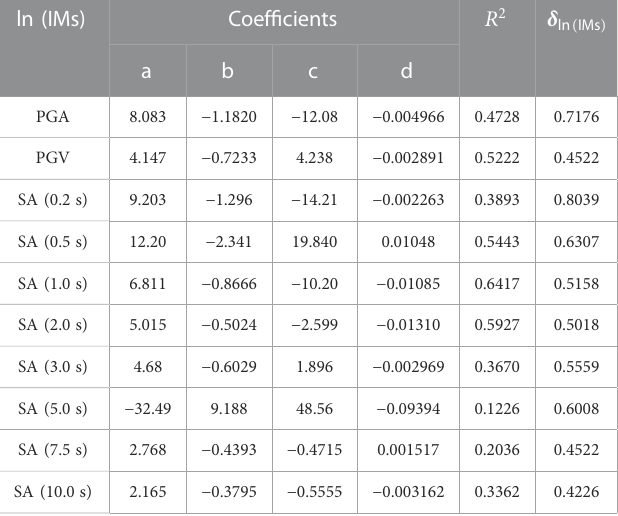
TABLE 2 Regression results for attenuation of various intensity measures (IMs) with R rup ln